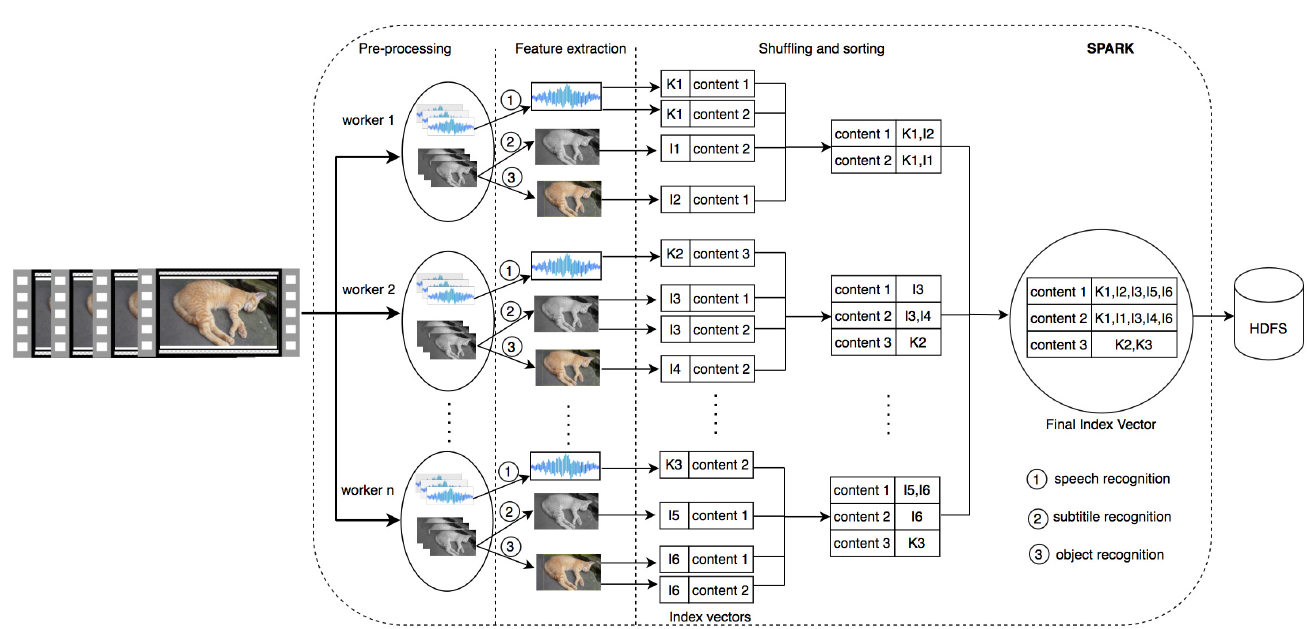
Figure 7. The proposed model of the distributed and parallel computing for feature extraction.